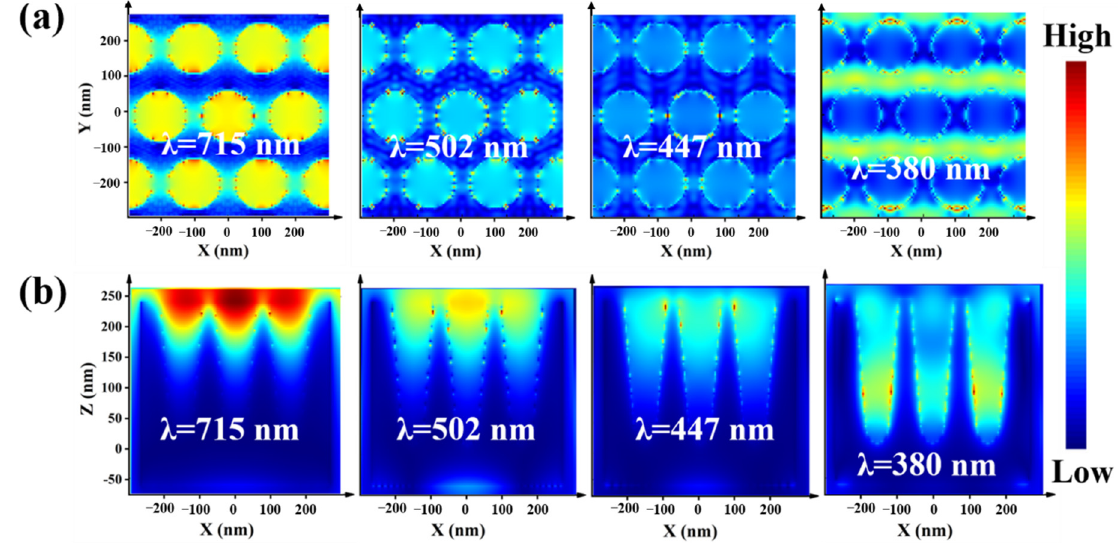
Figure 4. The “hot spot” distribution of the hexagonal nanocavities array structure in the ( a ) XY and ( b ) XZ plane under the 715, 502, 447 and 380 nm wavelength. ( b ) XZ plane under the 715, 502, 447 and 380 nm